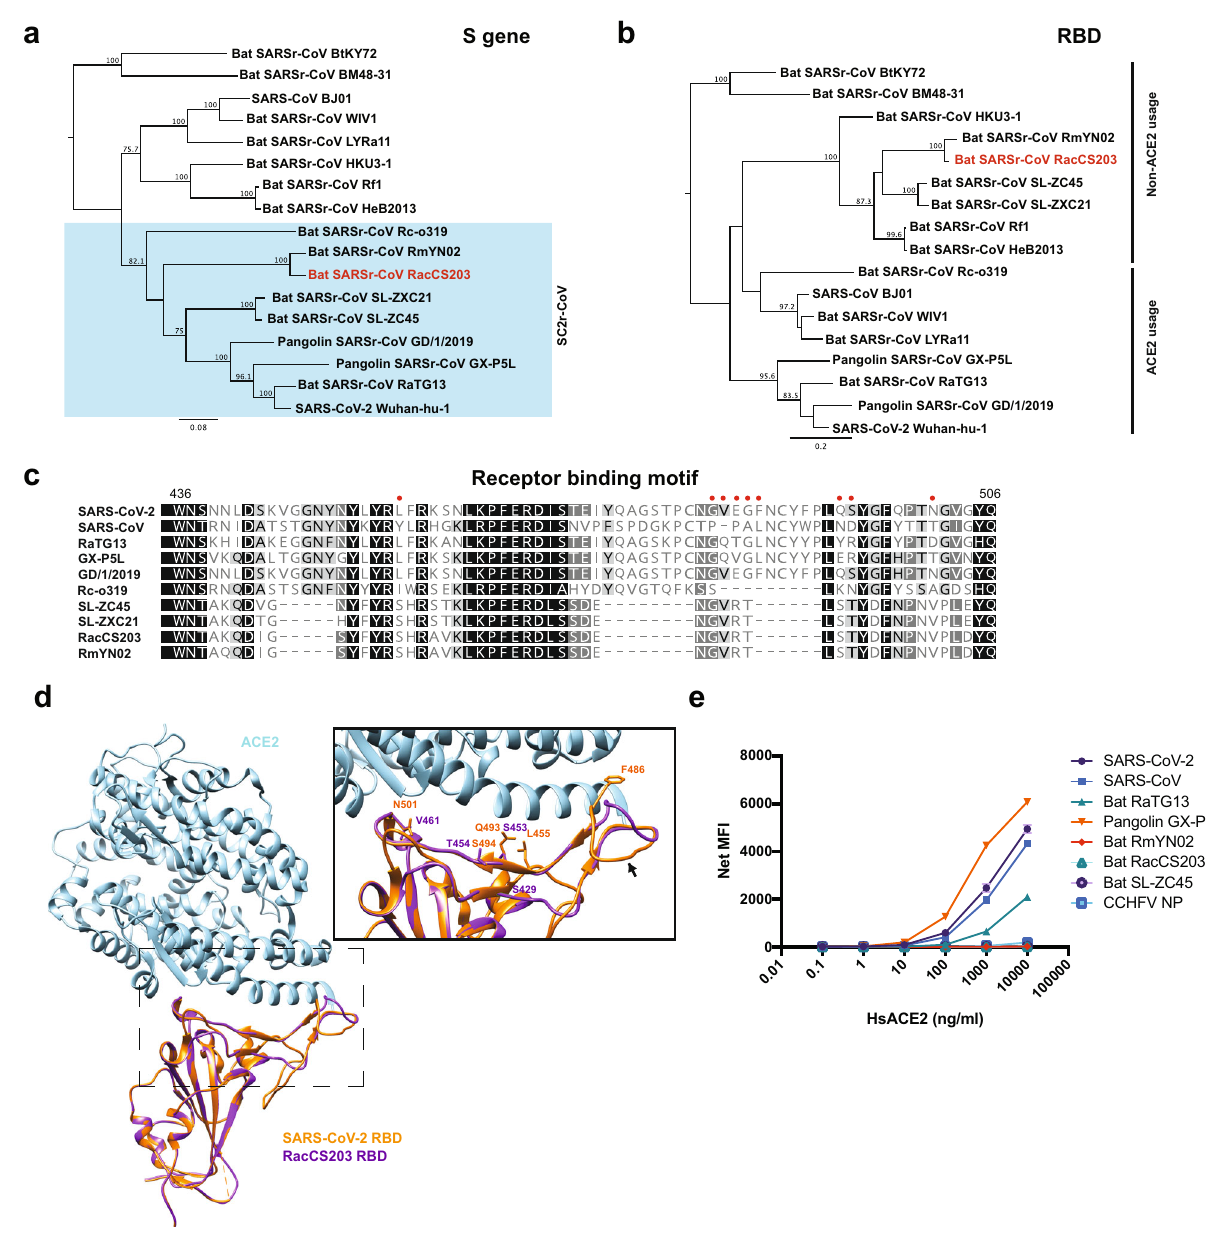
Fig. 2 Analysis of RBD sequences and function. a Phylogenetic tree based on the S gene sequences. b Phylogenetic tree based on the nucleotide sequences of the RBD coding regions. The trees in a and b were generated using PhyML with substitution model GTR and 1000 bootstraps. Numbers (>70) above or below the branches are percentage bootstrap values for the associated nodes. The scale bar represents the number of substitutions per site. c Amino acid sequence comparison of the receptor binding motif (RBM) of seven SARSr-CoVs with the red dots indicating amino acid residues critical for ACE2 interaction. d Structural modeling of the RBD-hACE2 interaction for RacCS203 based on the known structure of the SARS-CoV-2 RBD. e Multiplex binding assay to measure af fi nity of different SARSr-CoV RBDs to PE-conjugated hACE2. Data presented were derived from three independent experiments. Error bars indicate standard deviation. Graph was plotted using GraphPad Prism